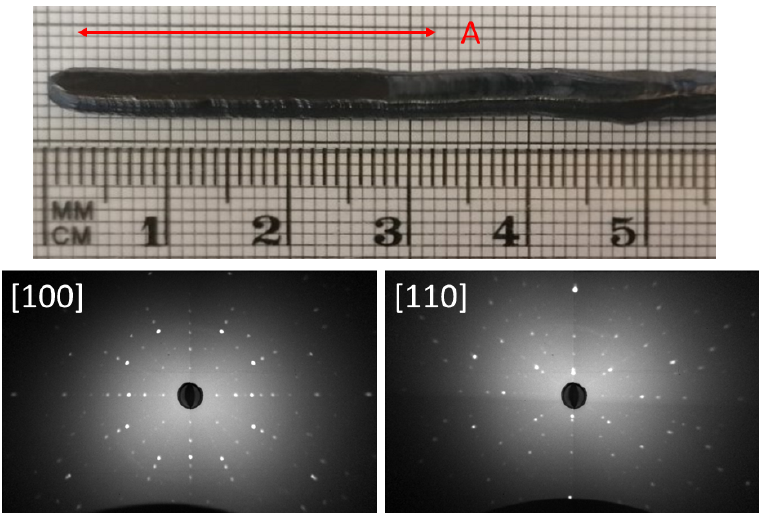
Figure 5. As-grown crystal boule of Mn 3 Al 2 Ge 3 O 12 (sample labeled MAGG_C2), prepared by the floating zone technique, in nitrogen gas atmosphere, at a pressure of 1 bar, using a growth rate of 20 mm h − 1 ( top ). A single crystal of ∼ 3 cm length was isolated from the Mn 3 Al 2 Ge 3 O 12 crystal boule, labeled as region A. Also shown are the X-ray Laue back reflection photographs showing the [100] and [110] orientations of an aligned sample used for magnetic properties measurements ( bottom ).